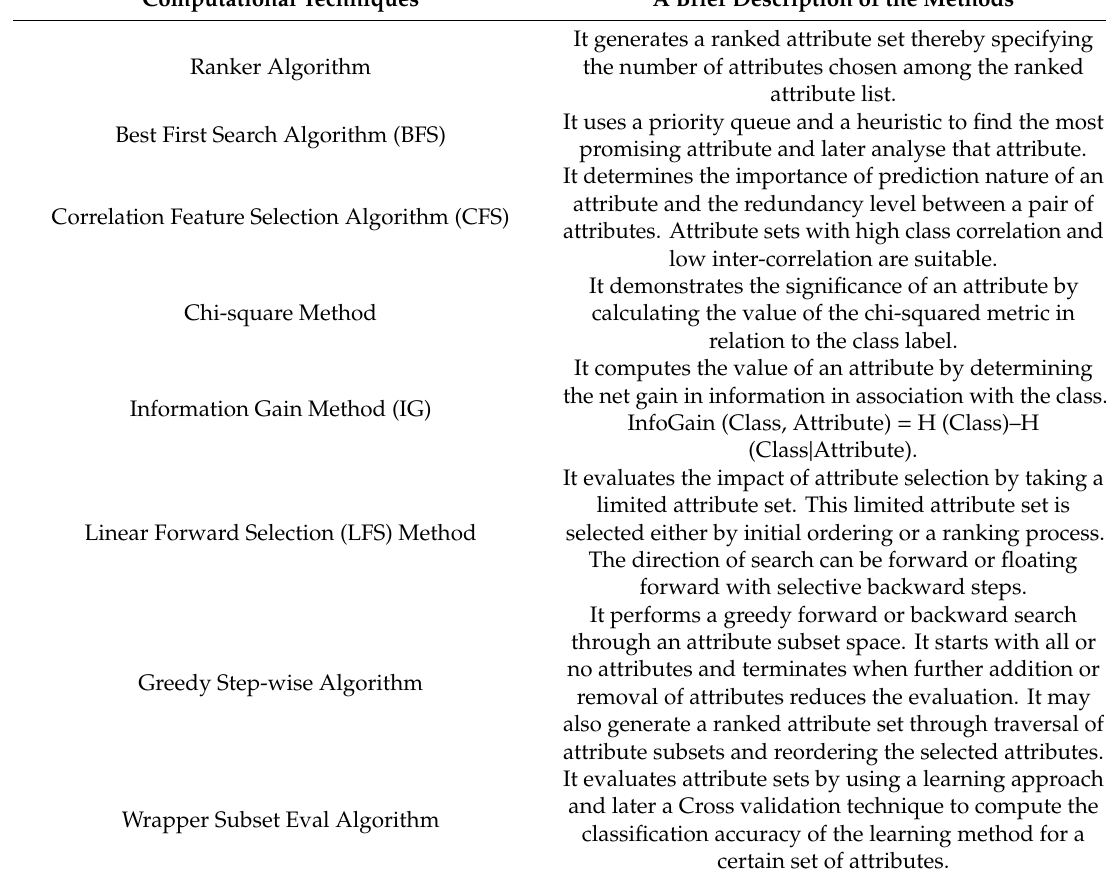
Table 6. Computational Methods used in the study.